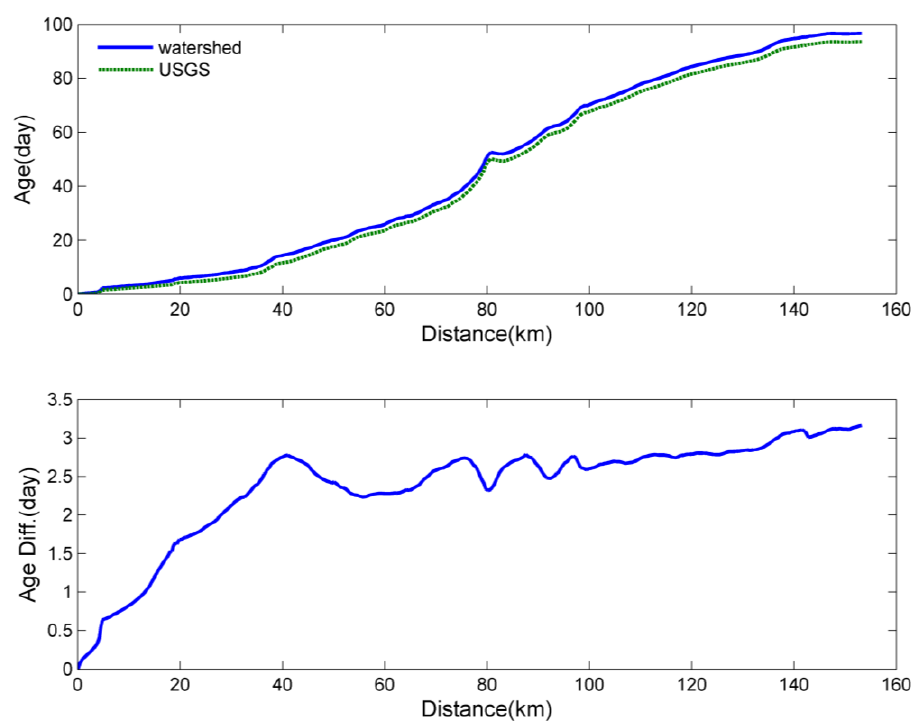
Figure 11. Mean water age and difference along the James River for the period of 2002 to 2008 with respect to different freshwater discharge.